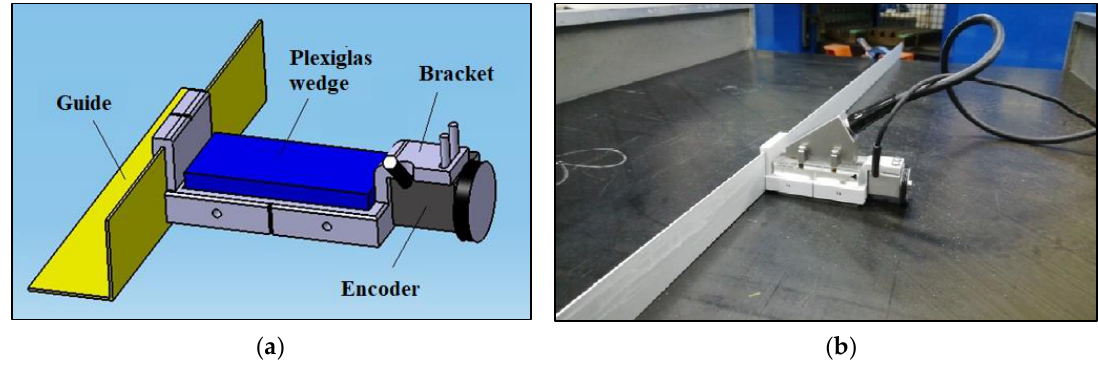
Figure 4. ( a ) CATIA assembly view of new PLA bracket tool and ( b ) experimental setup for ultrasonic C-scan controls around simulated impact zone of aeronautical component.